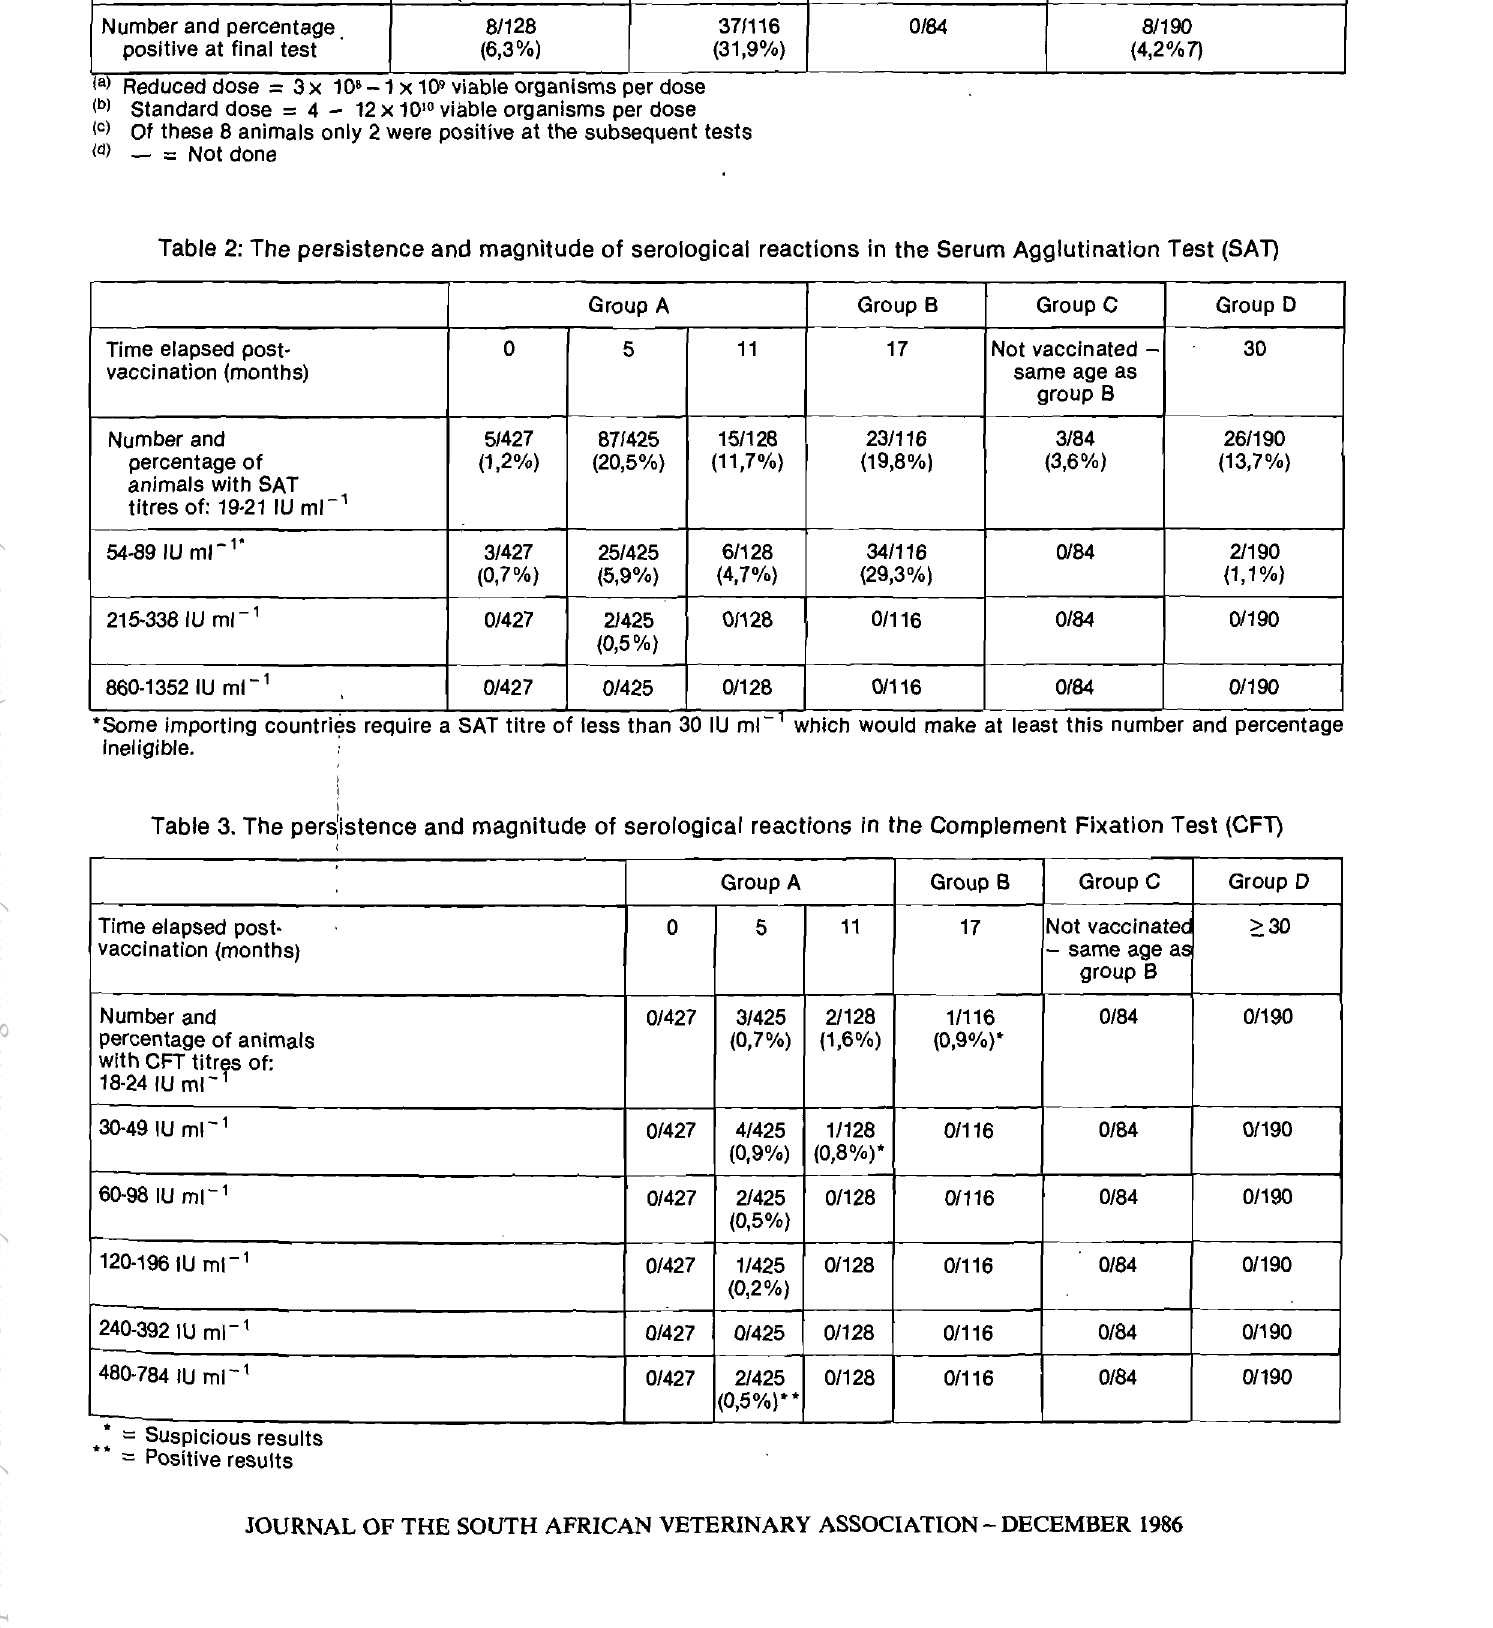
Table 2: The persistence and magnitude of serological reactions in the Serum Agglutination Test (SAT)